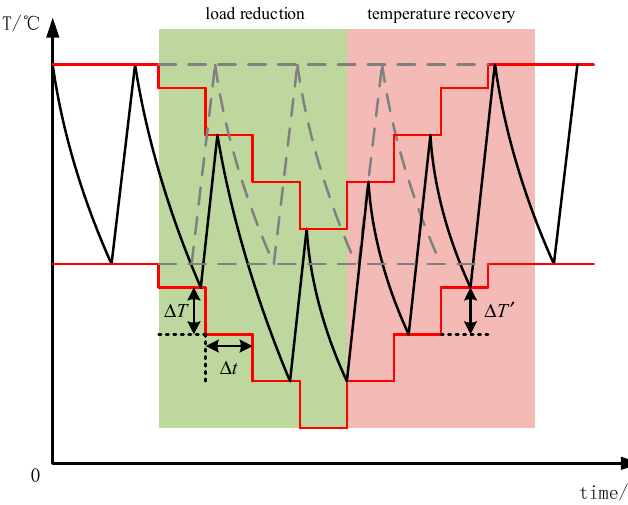
Figure 9. The demand response process of an air conditioning system.